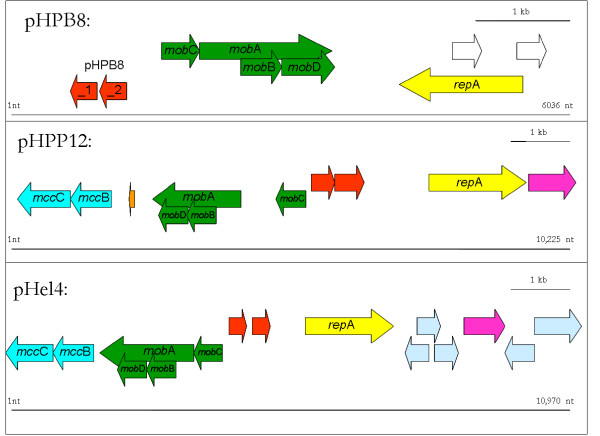
Functional alignment of the three plasmids of the H. pylori strains B8 (pHPB8), P12 (pHPP12), and HPP8 (pHel4). Homologuous genes are shown in the same color. The cluster of mob-genes (green) and the repA-gene (yellow) are present in all three plasmids. Genes homologuous to pHPB8_1 (plasmid stabilization system protein) and to pHPB8_2 (conserved hypothetical protein) are present in pHPP12 and pHel4 (red). The microcins mccC and mccB are not present in pHPB8. Genes that are not present in the other plasmids are colored white (pHPB8), orange (pHPP12) and light blue (pHel4).